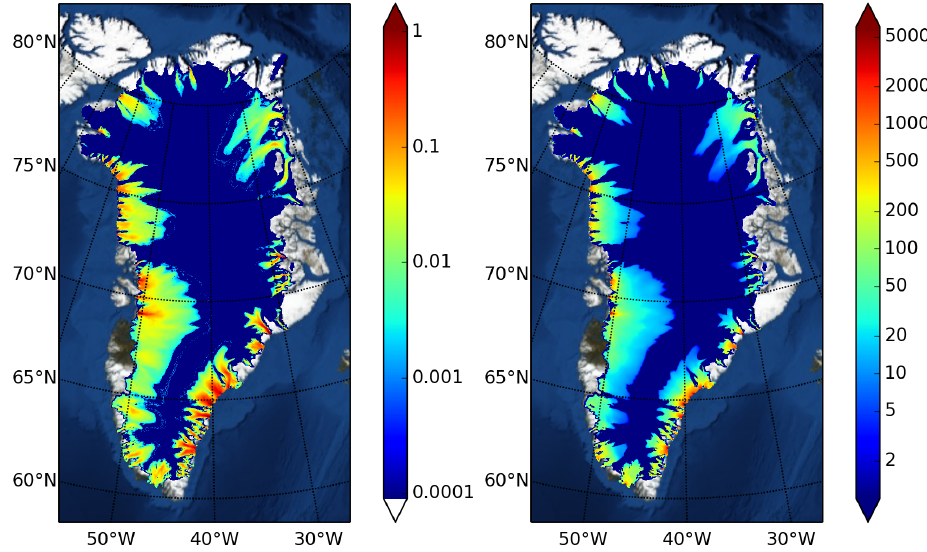
Figure 6. The inputs to the hydrology model are the modeled basal melt rate m/ρ w (left; ma − 1 ) and sliding speed | v b | (right; ma − 1 ) from the spun-up